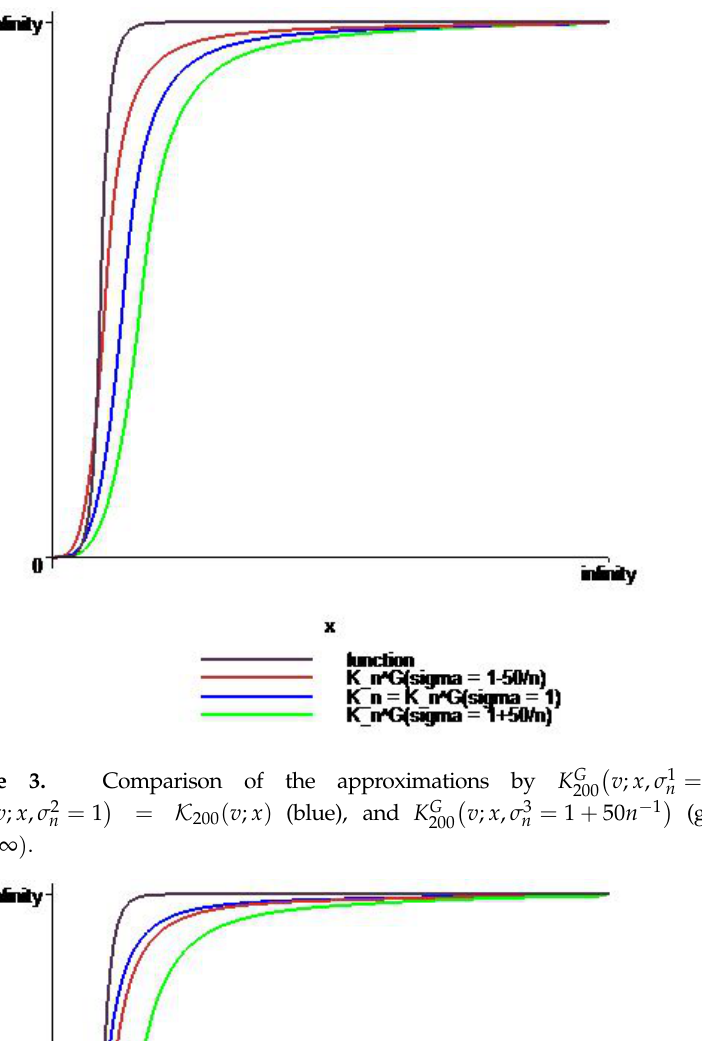
(cid:1) = K ( v ; x ) (blue), and K G 200